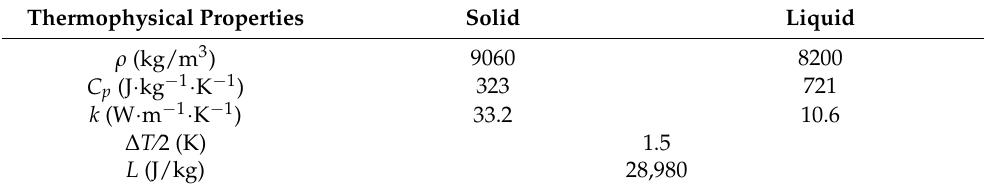
Table 1. The thermophysical properties of the 49Bi/21In/18Pb/12Sn alloy [14,40]. Thermophysical